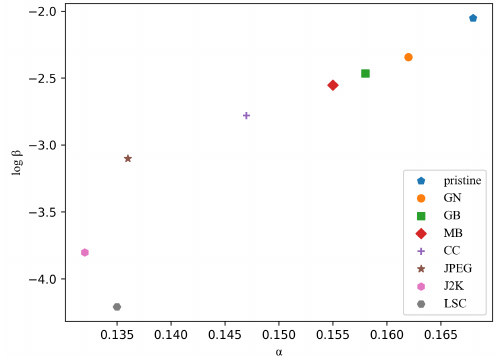
Figure 7. Distortion discrimination based on the GGD parameters fitted by the histogram of sparse coefficients for atom 1 of the learned dictionary. The legend represents the pristine image and the cor- responding distortion type for each set of parameters, including Gaussian Noise (GN), Gaussian Blur (GB), Motion Blur (MB), Contrast Change (CC), JPEG compression (JPEG), JPEG2000 compression (J2K), and Layer Segmentation based Coding (LSC).